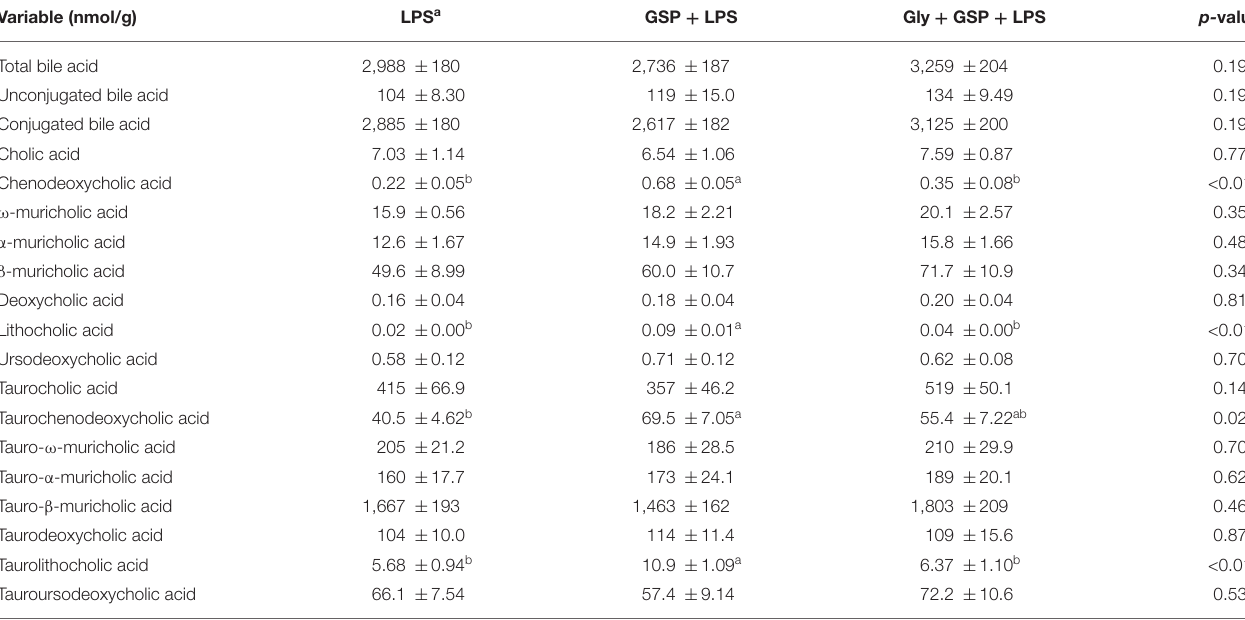
TABLE 3 | Hepatic BAs profiles of mice in Experiment